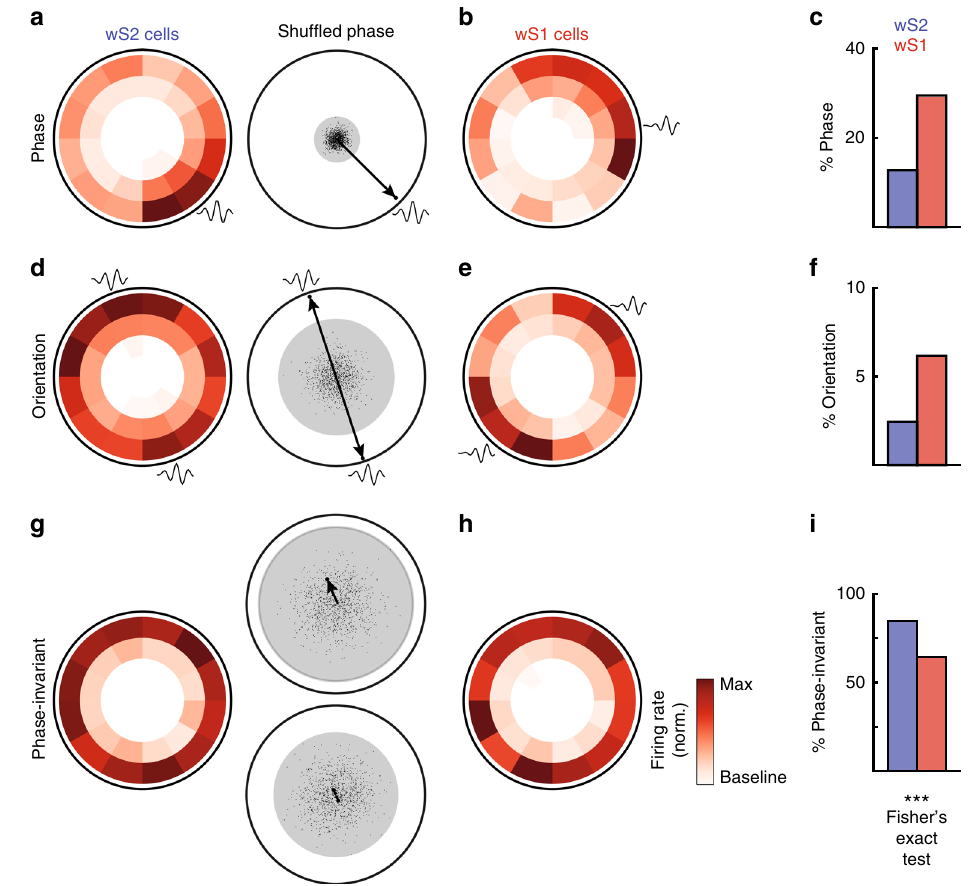
Fig. 2 Phase selectivity is less pronounced in wS2 compared to wS1. a Left: An example wS2 cell with selectivity for a region in the wS2 relevant subspace. Right: A graphical representation of the procedure for evaluating statistical signi fi cance. The vector sum (arrow) of all spike-eliciting stimuli is well outside of the phase-randomized distribution (dots, the gray zone encloses all 1000 shuf fl es, p < 0.001). The black stimulus shape at the border of the region is the preferred central phase. b An example wS1 cell with phase tuning as in a . c A regional comparison of the percentage of cells exhibiting phase tuning (wS2 = 12.7 and wS1 = 29.5%). d Left: An example wS2 cell that has selectivity for an orientation in the wS2 relevant subspace, which means it is equally tuned to two opposite phases. Right: a graphical representation of the procedure for evaluating statistical signi fi cance as in a . e An example wS1 neuron with orientation tuning displayed as in d . f A regional comparison of the percentage of cells exhibiting orientation tuning (wS2 = 2.5 and wS1 = 6.2%). g Left: An example wS2 cell with phase-invariant tuning in the wS2 relevant subspace. Right: A graphical representation of the procedure for evaluating statistical signi fi cance. This neuron fails both phase (top) and orientation-randomized shuf fl ing (bottom). h An example wS1 cell with phase-invariant tuning displayed as in g . i A regional comparison of the percentage of cells exhibiting phase-invariant tuning (wS2 = 84.8 and wS1 = 64.4%). The population differences are highly signi fi cant (Fisher ’ s exact test, p = 6.7e −